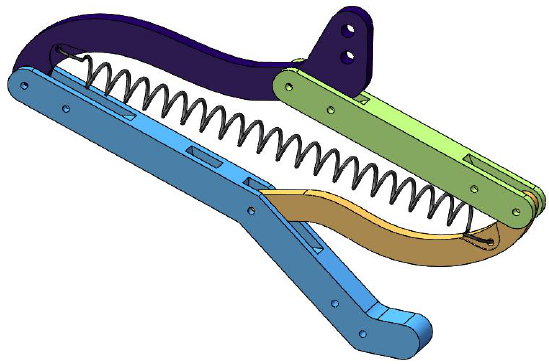
Figure 10. 3D model of hind limbs of the robot.